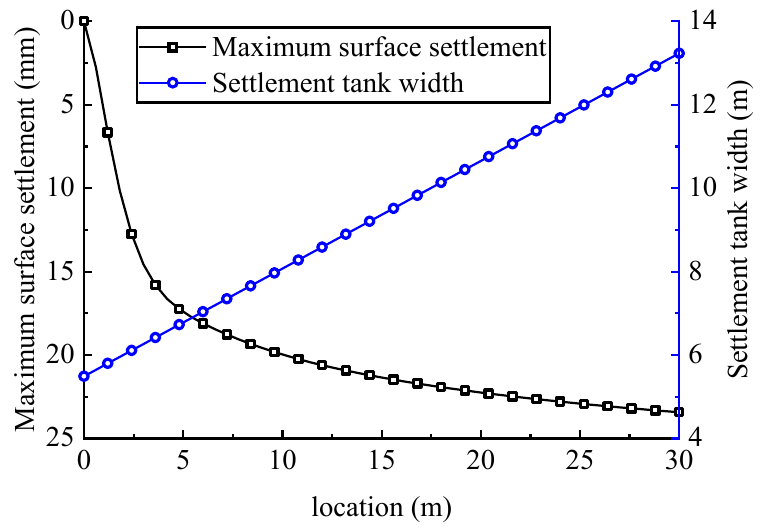
23.4 mm at the end of the pipe roofs.